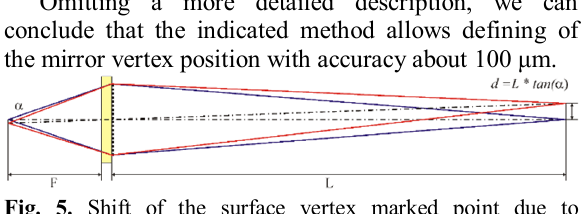
Fig. 3. Tetsing of stereoscopic system with two off-axis mirrors.